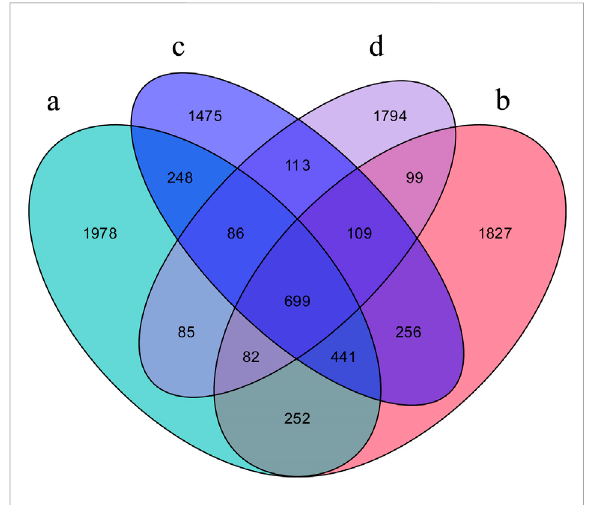
FIGURE 2 Number of observed taxonomic units (OTUs) in the soil. (A) litchi orchard with no intercropping; (B) litchi orchard intercropped with Desmodium ovalifolium ; (C) litchi orchard intercropped with Grona heterocarpos ; (D) litchi orchard intercropped with Stylosanthes guianensis